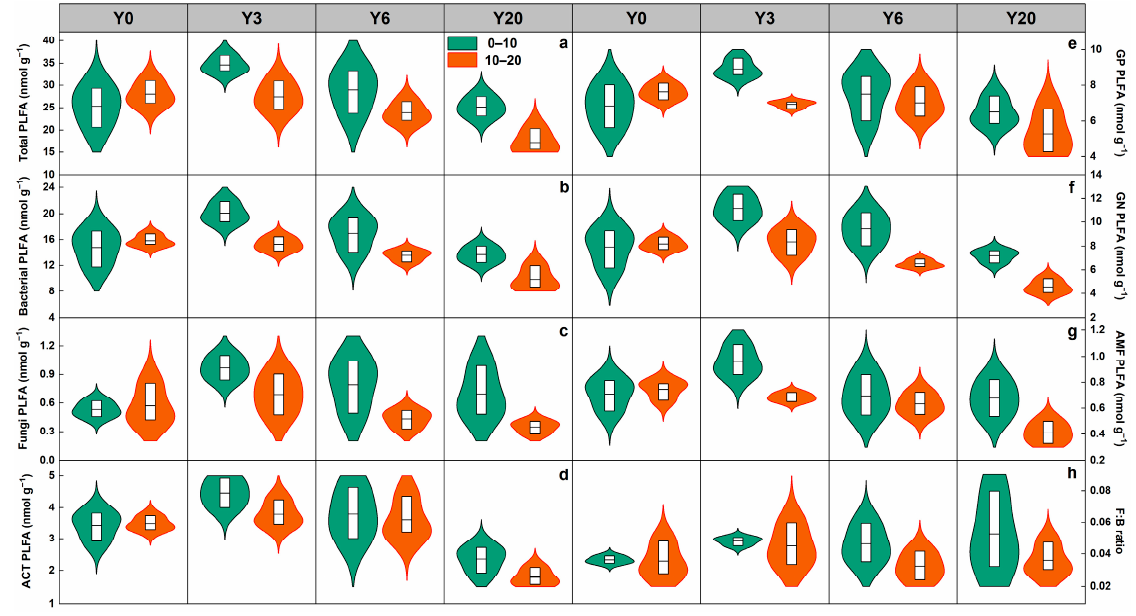
Figure 1. Total ( a ), bacterial ( b ), fungi ( c ), actinomycetes (ACT, ( d )), Gram-positive bacteria (GP, ( e )), Gram-negative bacteria (GN, ( f )), arbuscular mycorrhizal fungi (AMF, ( g )), and the ratio of fungi to bacteria (F:B ratio, ( h )) under different cropping years of mugwort. Y0: continuous maize–wheat rotation; Y3: mugwort cropping for 3 years; Y6: mugwort cropping for 6 years; Y20: mugwort cropping for 20 years.